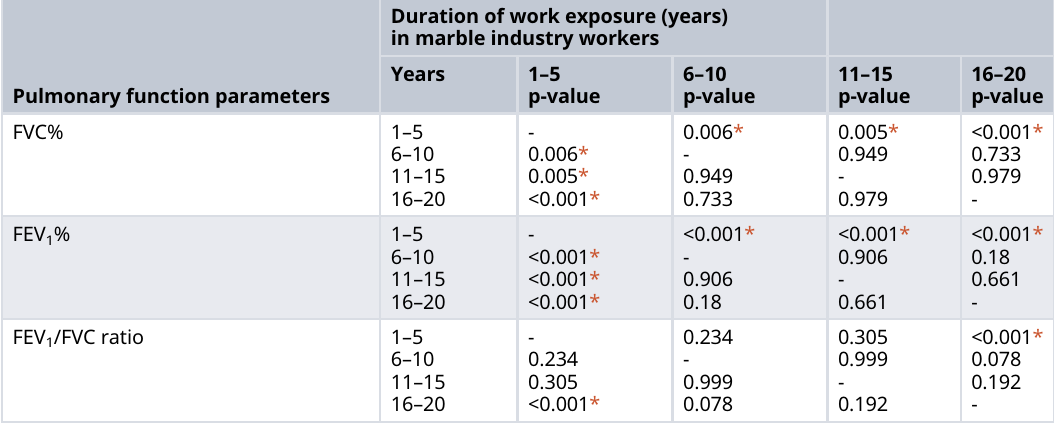
Table 5. Pairwise comparison of pulmonary function parameters among marble workers by years of